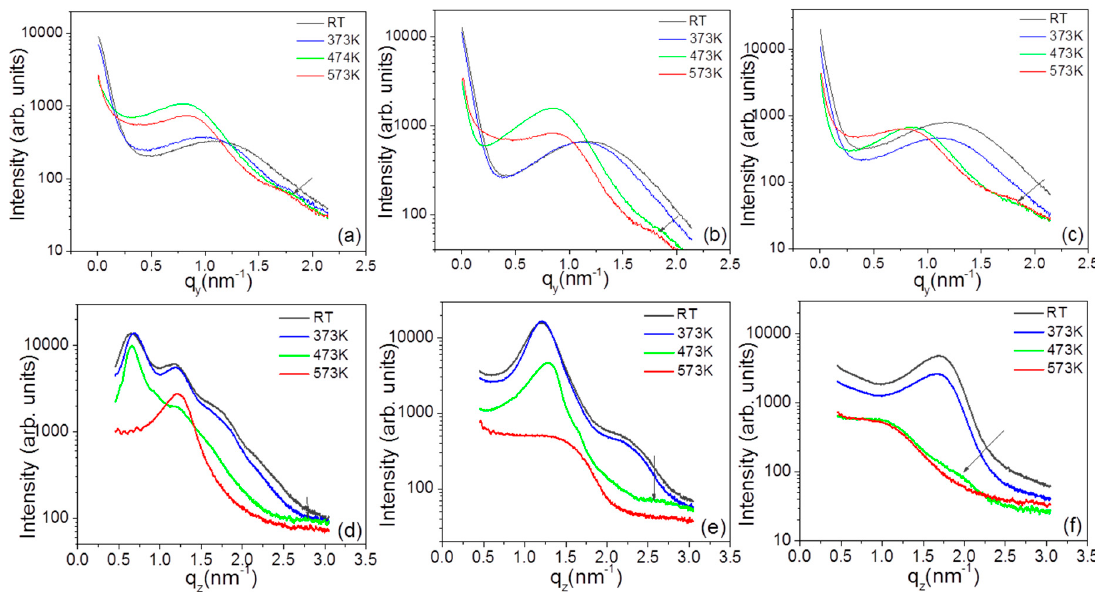
Figure 4. Directional cuts obtained from MLs at various temperatures. Yoneda cuts (horizontal) are shown in ( a – c ) and off-detector cuts (vertical) are shown in ( d – f ) for the MLs Au/PPFC_1, Au/PPFC_2, and Au/PPFC_3, respectively. In each plot, the arrow at higher q values denotes the presence of a higher order peak.